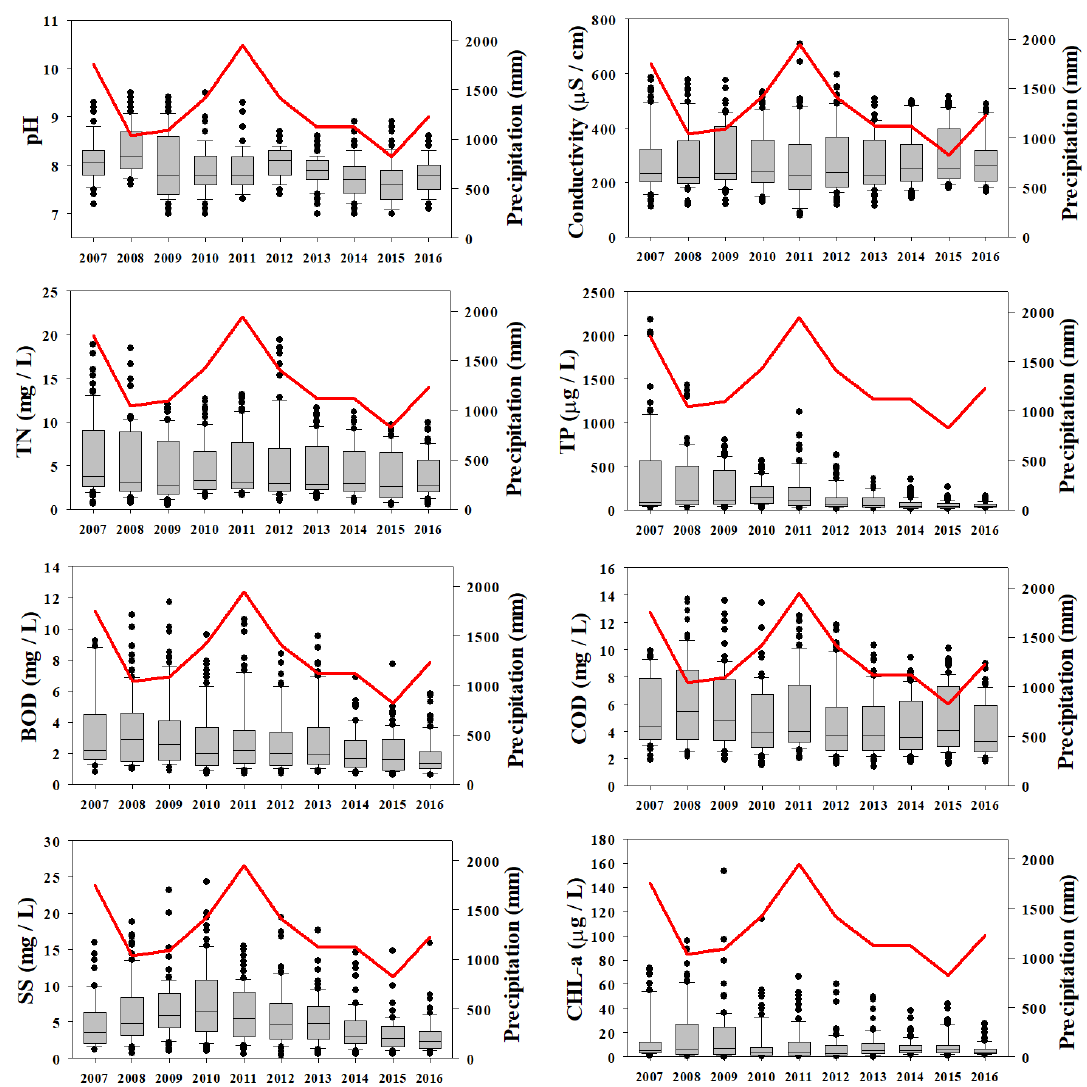
Figure 3. Annual variation in water quality parameters in relation to annual precipitation (shown as red curve) in Gap-stream during 2007–2016 (TN = Total nitrogen, TP = Total phosphorus, BOD = Biological oxygen demand, COD = Chemical oxygen demand, SS = Suspended solids, CHL-a = Chlorophyll-a).